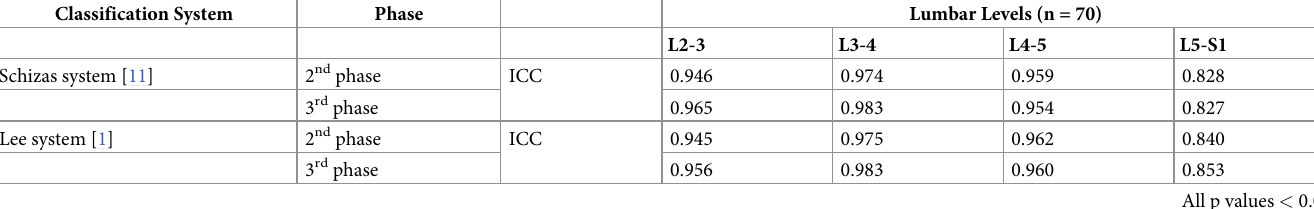
Table 3. Intra-class correlation coefficient reliabilities for inter-observer agreement of the Schizas and Lee systems. Classification System